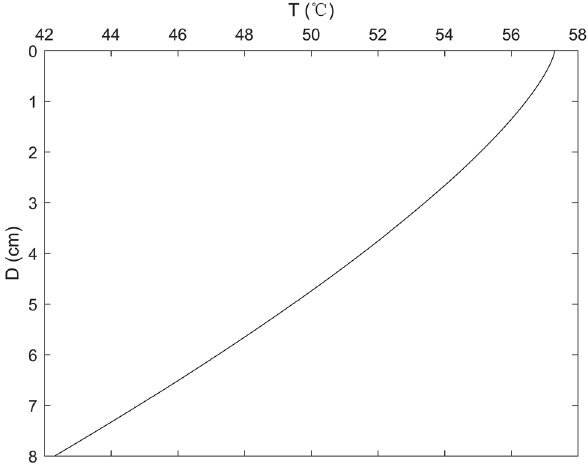
Figure 3. Temperature profile along the depth of deck pavement.